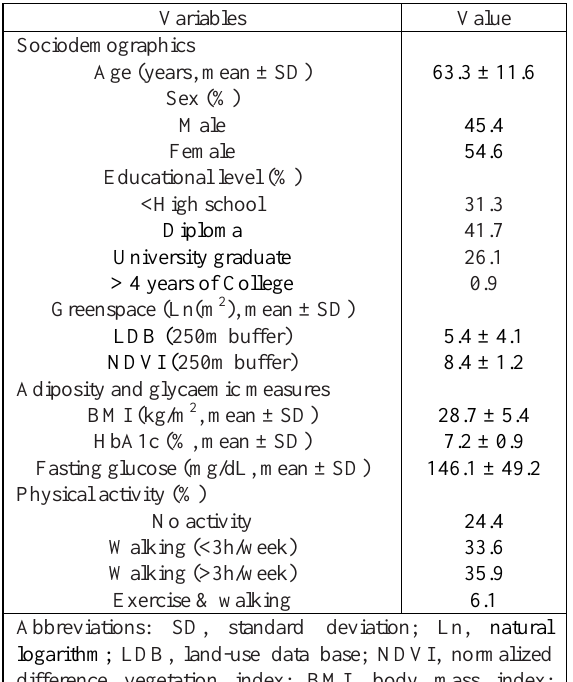
Table 1. Baseline characteristics of the Longitudinal study follow-up